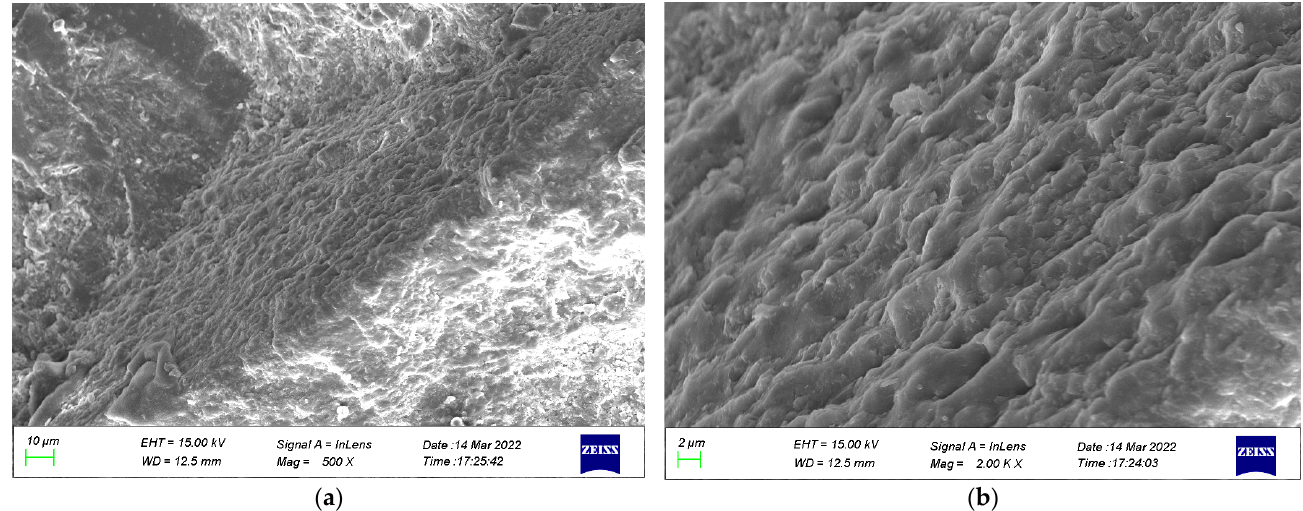
Figure 16. Micro-structure of aggregate, WER content 0%: ( a ) 500×; ( b ) 2000×.